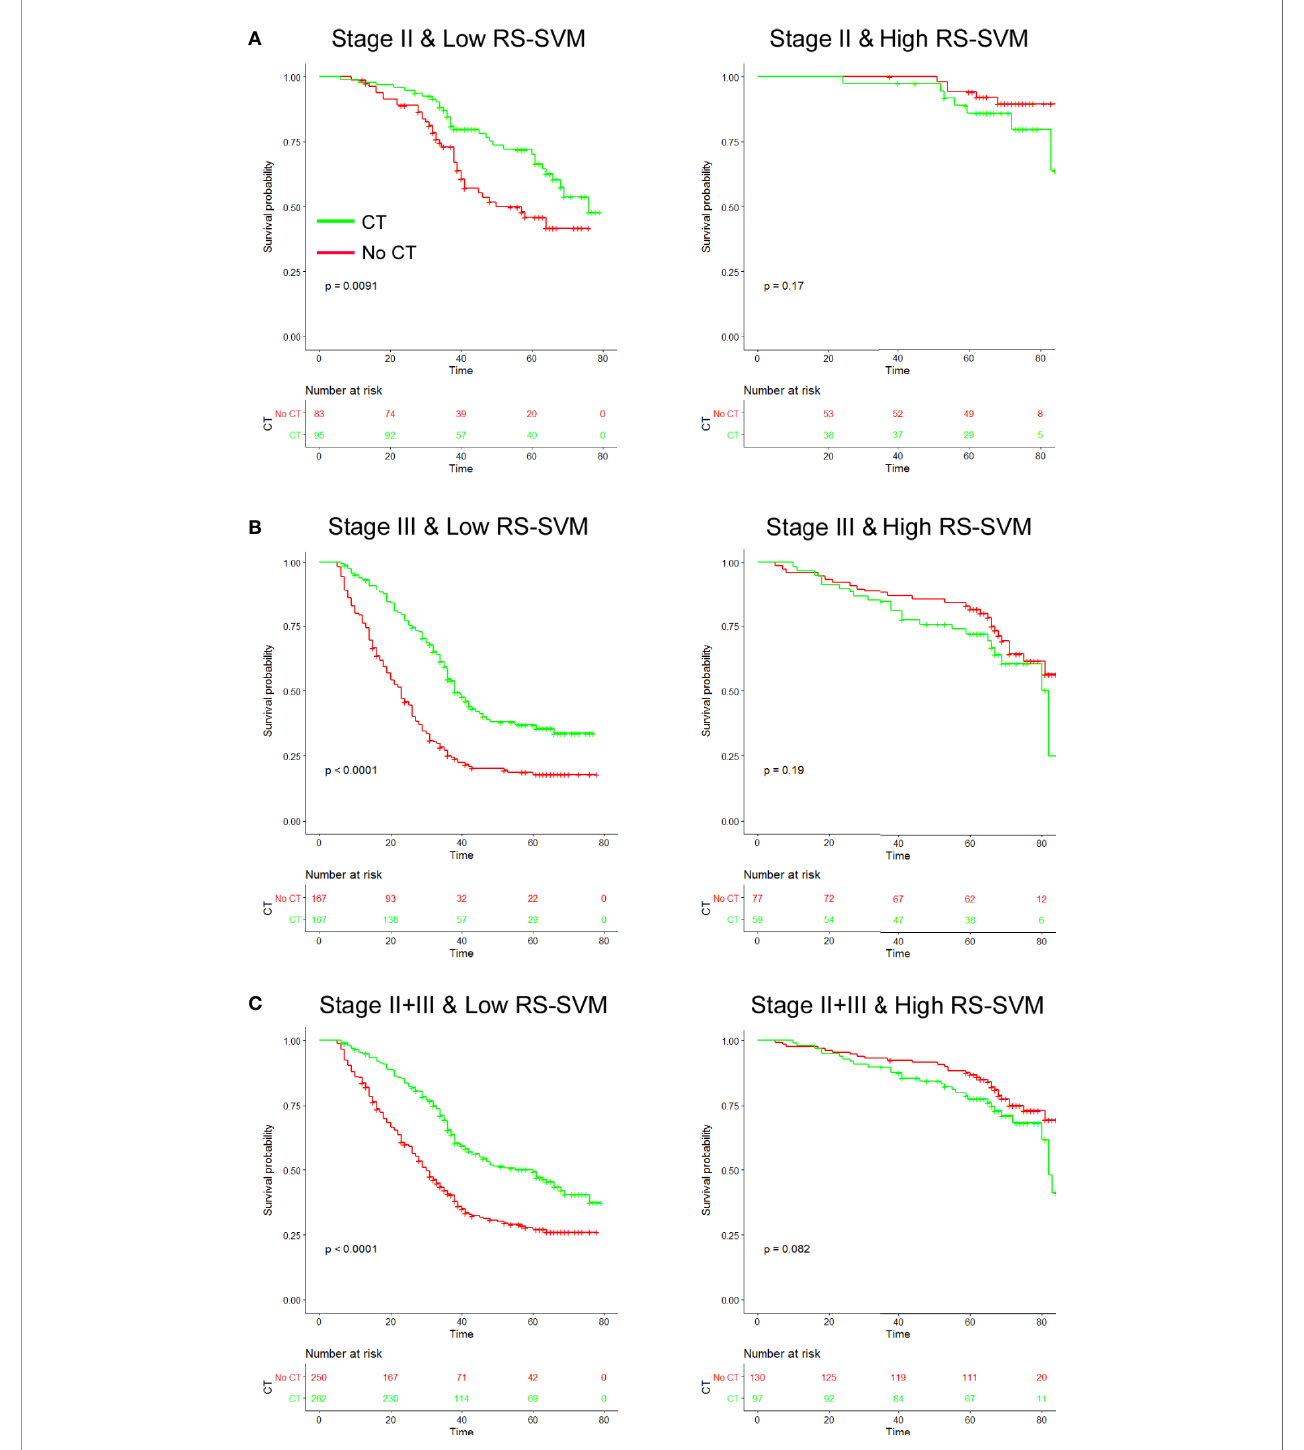
FIGURE 4 | Chemotherapy bene fi ts in gastric cancer compared using disease-free survival (DFS). Kaplan-Meier survival curves for patients with gastric cancer in different radiomics score subgroups, which were strati fi ed by the receipt of chemotherapy (A) . Training cohort (n=286) (B) , validation cohort (n=453), and (C) combined cohort (n=739). CT, chemotherapy; RS, radiomics